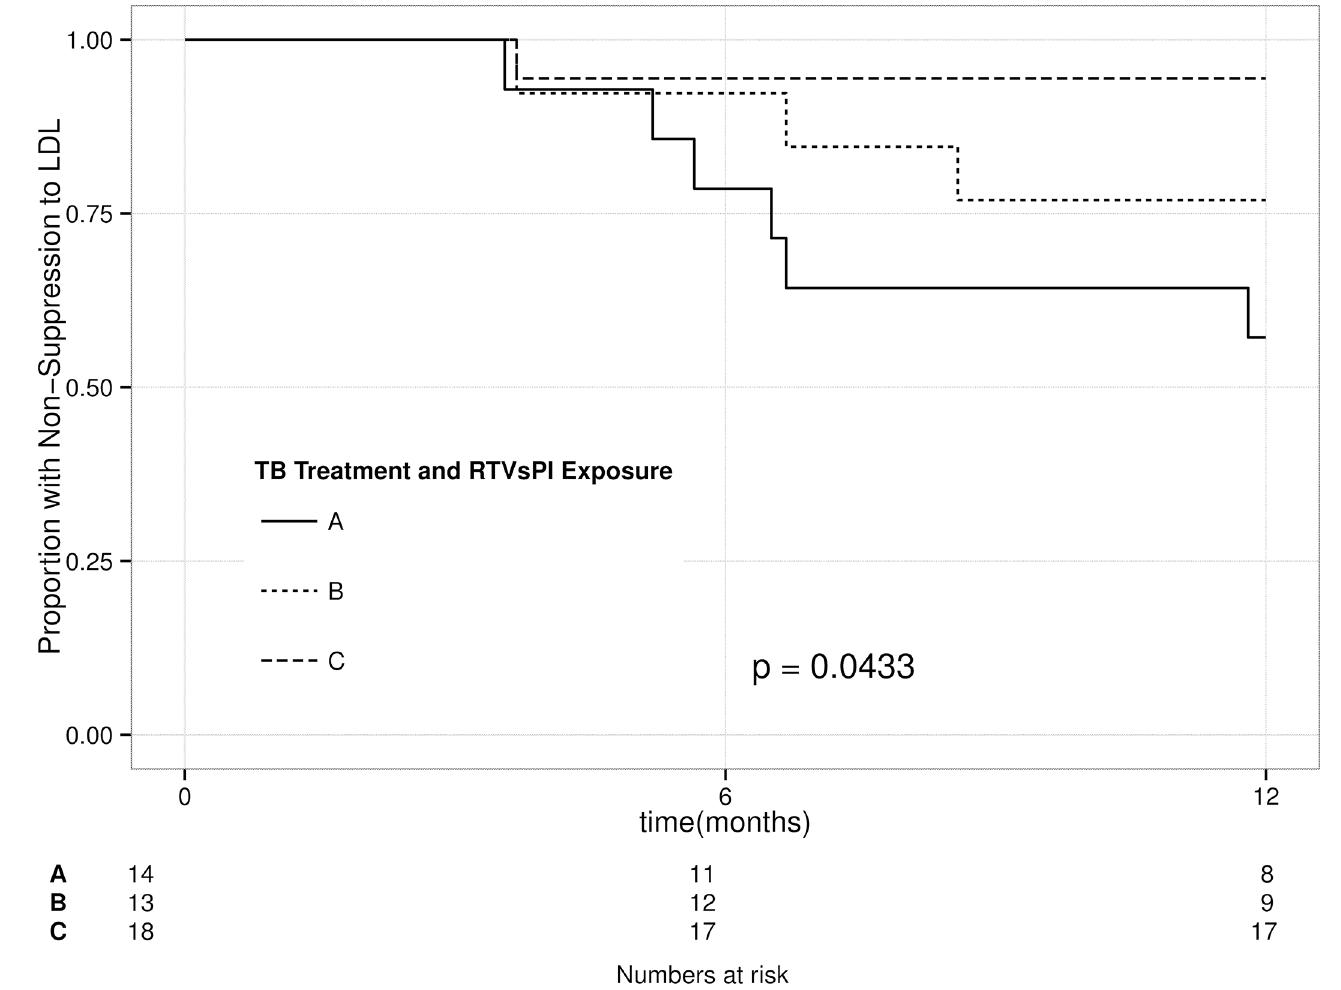
Fig 2. Kaplan-Meier curve of time to virological suppression among children with or without use of ritonavir as single protease inhibitor (RTV-sPI) at the time of protease inhibitor (PI) initiation. Groups: (A) No RTV-sPI exposure or history of exposure to TB therapy; (B) No RTV-sPI exposure, on TB treatment at time of PI initiation; (C) History of RTV-sPI exposure, and on TB treatment at time of PI initiation.